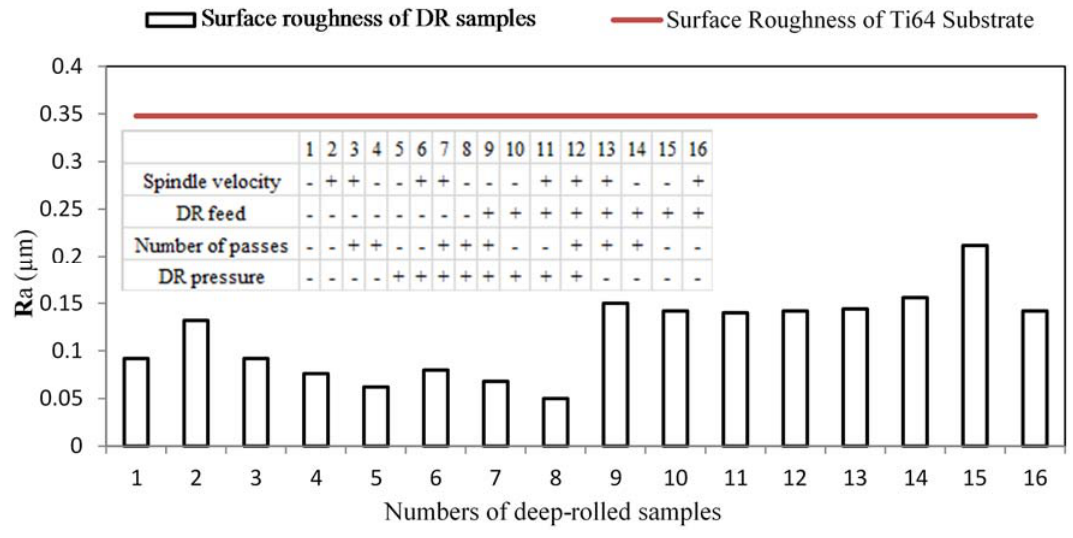
Figure 5. Surface roughness improvement of DR-treated Ti64. The surface roughness of the non-treated Ti64 is represented by a horizontal line at 0.35 µm. The DR parameters of the 16 samples are in the embedded legend and correspond to those in Table